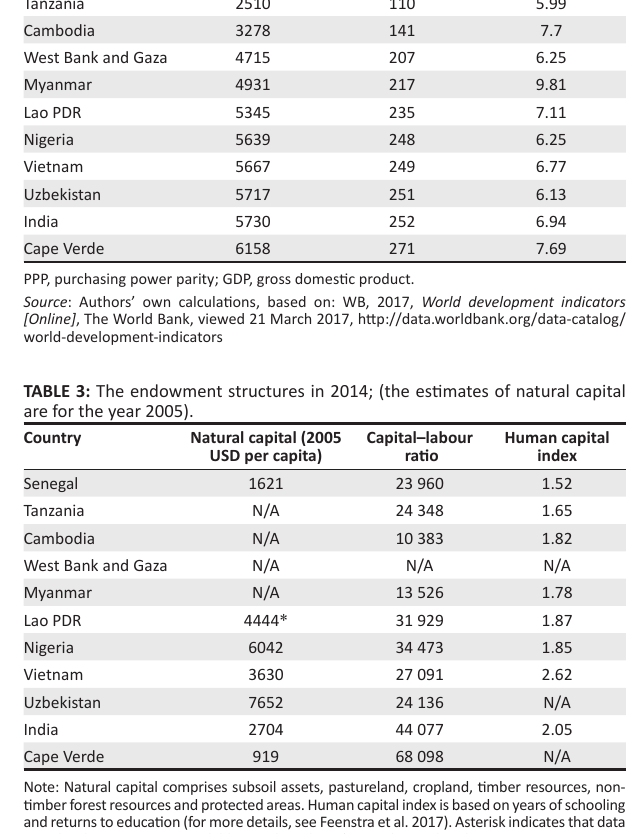
TABLE 2: Gross domestic product per capita, purchasing power parity (constant 2011 USD) in 2015 and average annual gross domestic product growth rates (1995–2015). Country GDP per capita, GDP per capita, PPP Average (real) GDP PPP (USD) ( % of Senegal) growth rate ( % )